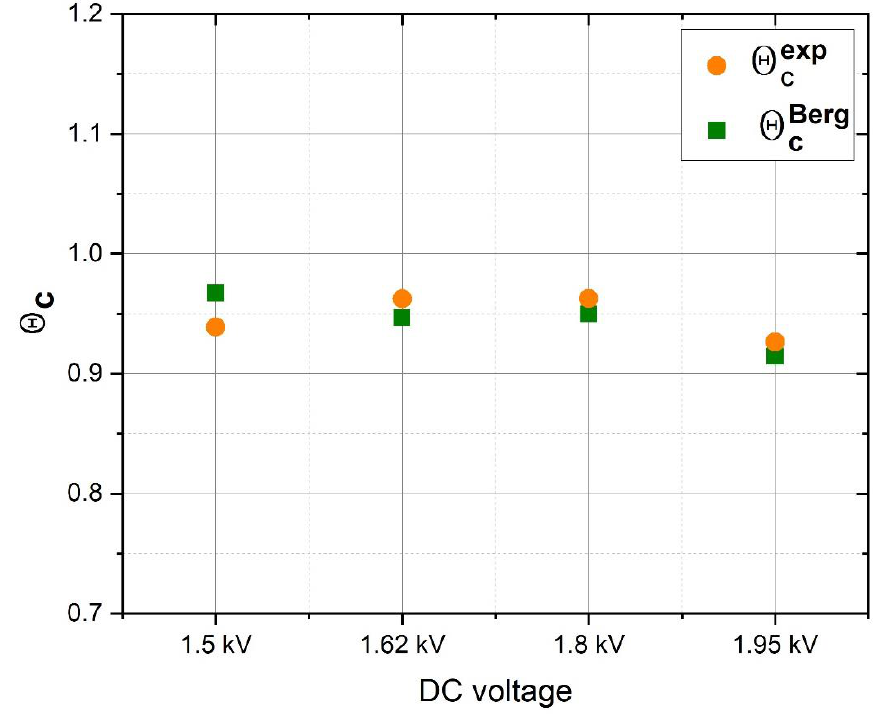
Figure 7. Experimental and Berg modelled data of the first point of the samples at various DC potentials.